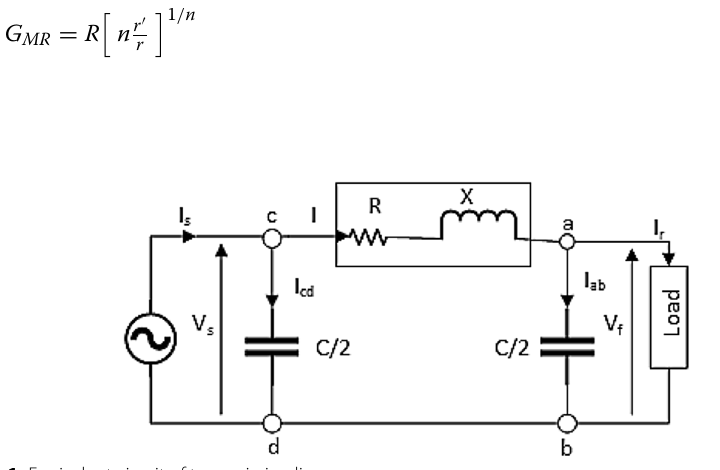
Fig. 1 Equivalent circuit of transmission